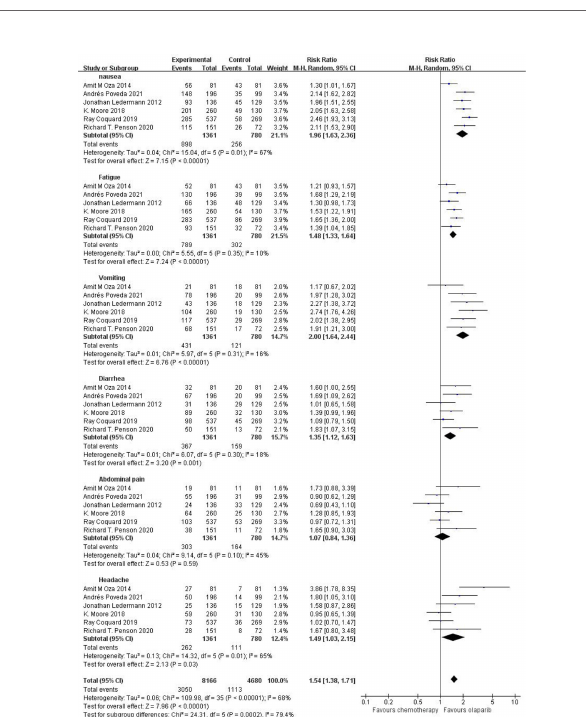
FIGURE.4 | Meta-analysis results of adverse reactions above grade 3 between control group and olaparib group.